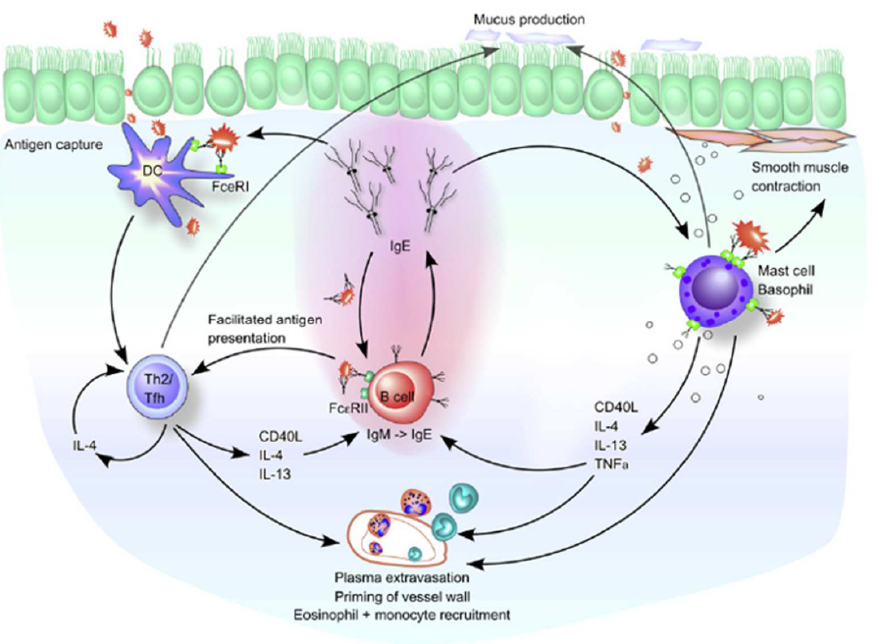
Figure 3. Role of CD23+/Fc ε RII and IgE in allergic airway diseases. DCs initially take up inhaled antigens in an atopic environment and result in a predominant induction of Th2 cells. Th2 cells potentially induce IgE-producing B cells through the production of IL-4 and IL-13. The resulting IgE then binds to its high-affinity (Fc ε RI) and low-affinity (CD23+/Fc ε RII) receptors on the airway mucosa cells. The binding of Fc ε RI-bound IgE to the allergen on mast cells and basophils causes degranulation and release of inflammatory mediators and cytokines, leading to immediate hyper- sensitivity symptoms. The late-phase response begins when the released Th2 cytokines (IL-4, IL-5, and IL-13) recruit and activate the inflammatory cells, such as monocytes and eosinophils. IL-4 and IL-13 also cause excessive mucus production by goblet cells. Elevated local IgE levels induce Fc ε RI expression on DCs and stabilize CD23+/Fc ε RII on B cells. Therefore, in a Th2-skewing environment, these cell types can take up allergen-IgE complexes and present the allergen to T cells. For B cells bearing CD23+/Fc ε RII, this is called facilitated antigen presentation because it occurs in a noncognate manner. Reprinted with permission from Ref. [43]. Copyright 2022 Journal of Allergy and Clinical Immunology.Chary et al. reported that children with asthma had a higher proportion of B cells with CD23+ expression than controls [44]. CD23+ expression of lymphocytes among children with asthma (due to allergic response) increases and is positively associated with serum IgE levels [40]. Excessive expression of CD23+ in patients with extrinsic asthma results from excessive IL-4 pro- duction by allergen-specific T cells [45]. The expression of CD23+ has been associated with allergic diseases. Anti-CD23 therapy may be a promising candidate therapy for allergic diseases in the future. Anti-CD23 might induce tolerance, block antigen presentation, suppress T-cell differentiation, and diminish APC activation in allergic reactions